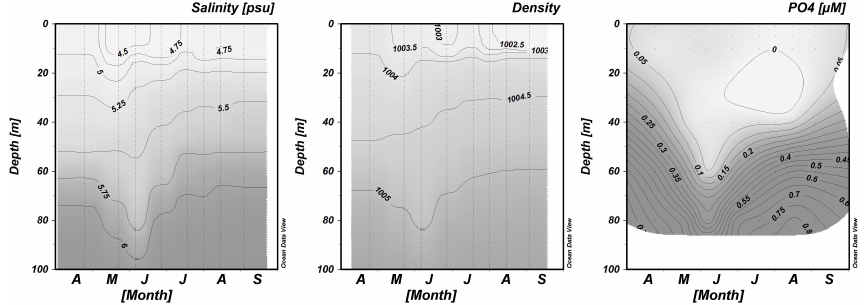
Fig. 3. Time series of salinity, density and PO 2 − in the upper 100m at the Bothnian Sea station (C3) during 2006. This figure was prepared 4 with Ocean Data View using DIVA gridding.